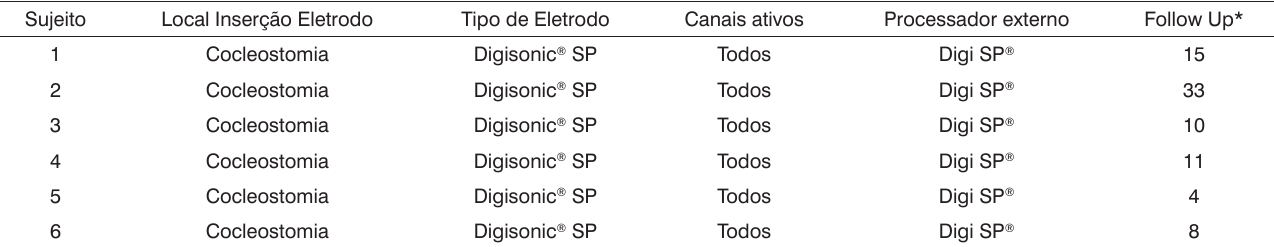
Tabela 3. Dados específicos dos pacientes implantados. Sujeito